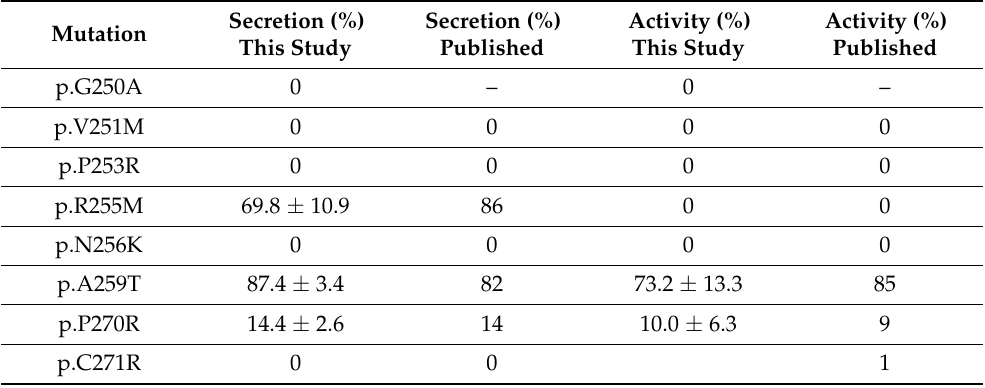
Table 2. Secretion of CPA1 variants from transfected HEK 293T cells and CPA1 activity of the activated conditioned medium (given as % of wild-type CPA1 secretion and activity, mean ± standard deviation, n = 5–9). Values published previously are also listed